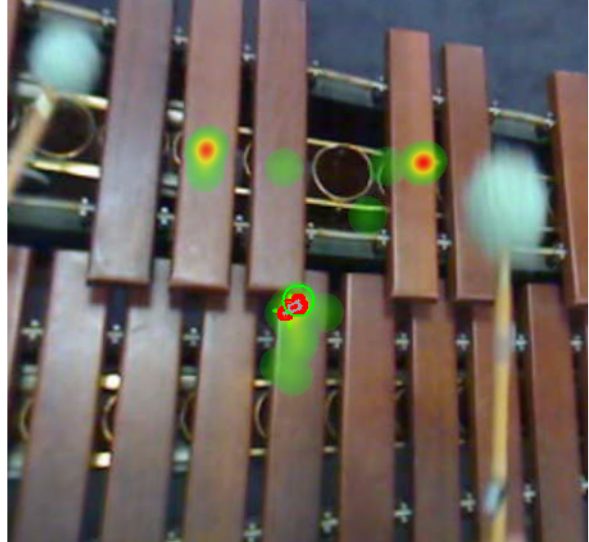
Figure 6. Heatmap of a short excerpt of a musical piece where the xylophonist (Player #2) plays on both natural and accidental keys. The focal point differs between natural keys (the musi- cian’s gaze aims at the section where the accidental keys are su- perposed to the natural keys), and accidental keys (musician’s gaze aims at the middle of the bar, at the point of